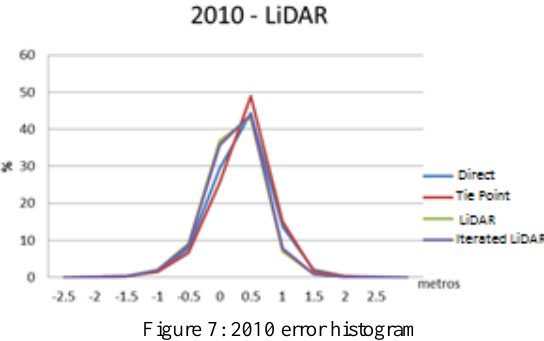
Figure 7: 2010 error histogram